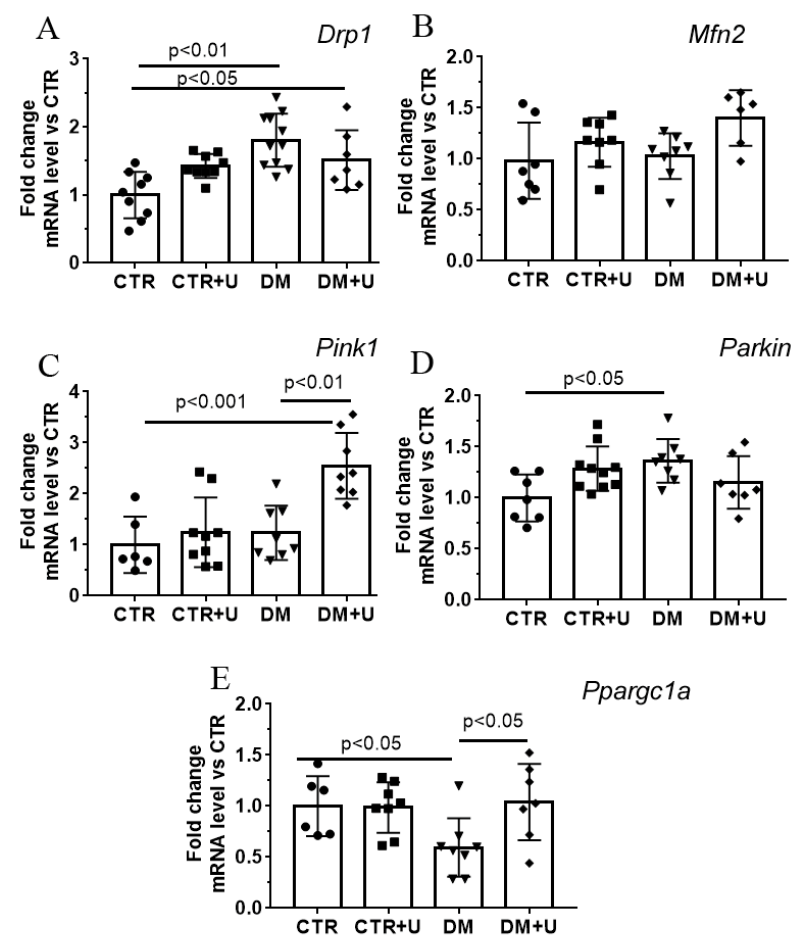
Figure 4. Effect of uridine treatment on mitochondrial homeostasis (the processes of mitochondrial fusion/fission, biogenesis, and mitophagy) in the diabetic heart. The relative mRNA levels of Drp1 ( A ), Mfn2 ( B ), Pink1 ( C ), Parkin ( D ), and Ppargc1a ( E ) in the heart of mice in the experimental groups. The values are given as means ± SD ( n = 6–10).